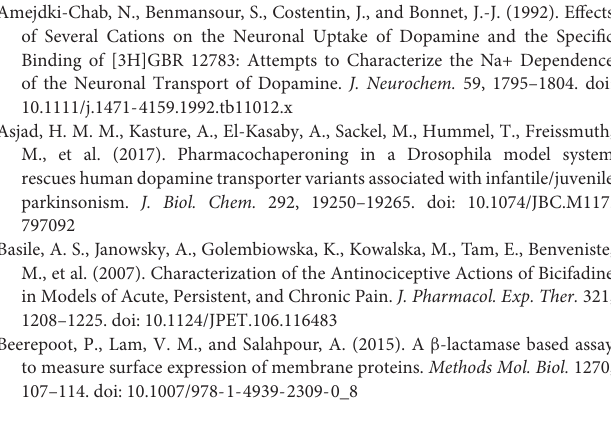
Supplementary Figure 1 | YFP-HA-DAT Immunoblot Bands. First lane: molecular weight ladder. Second lane: YFP-HA-DAT with two bands representing mature DAT (110 kDa) and immature, ER-resident DAT (75 kDa). Supplementary Figure 2 | Dose response inhibition of dopamine uptake by bupropion on WT and YFP-HA- β lac-DAT. Data were normalized to vehicle treatment. Data are means ± S.E.M.